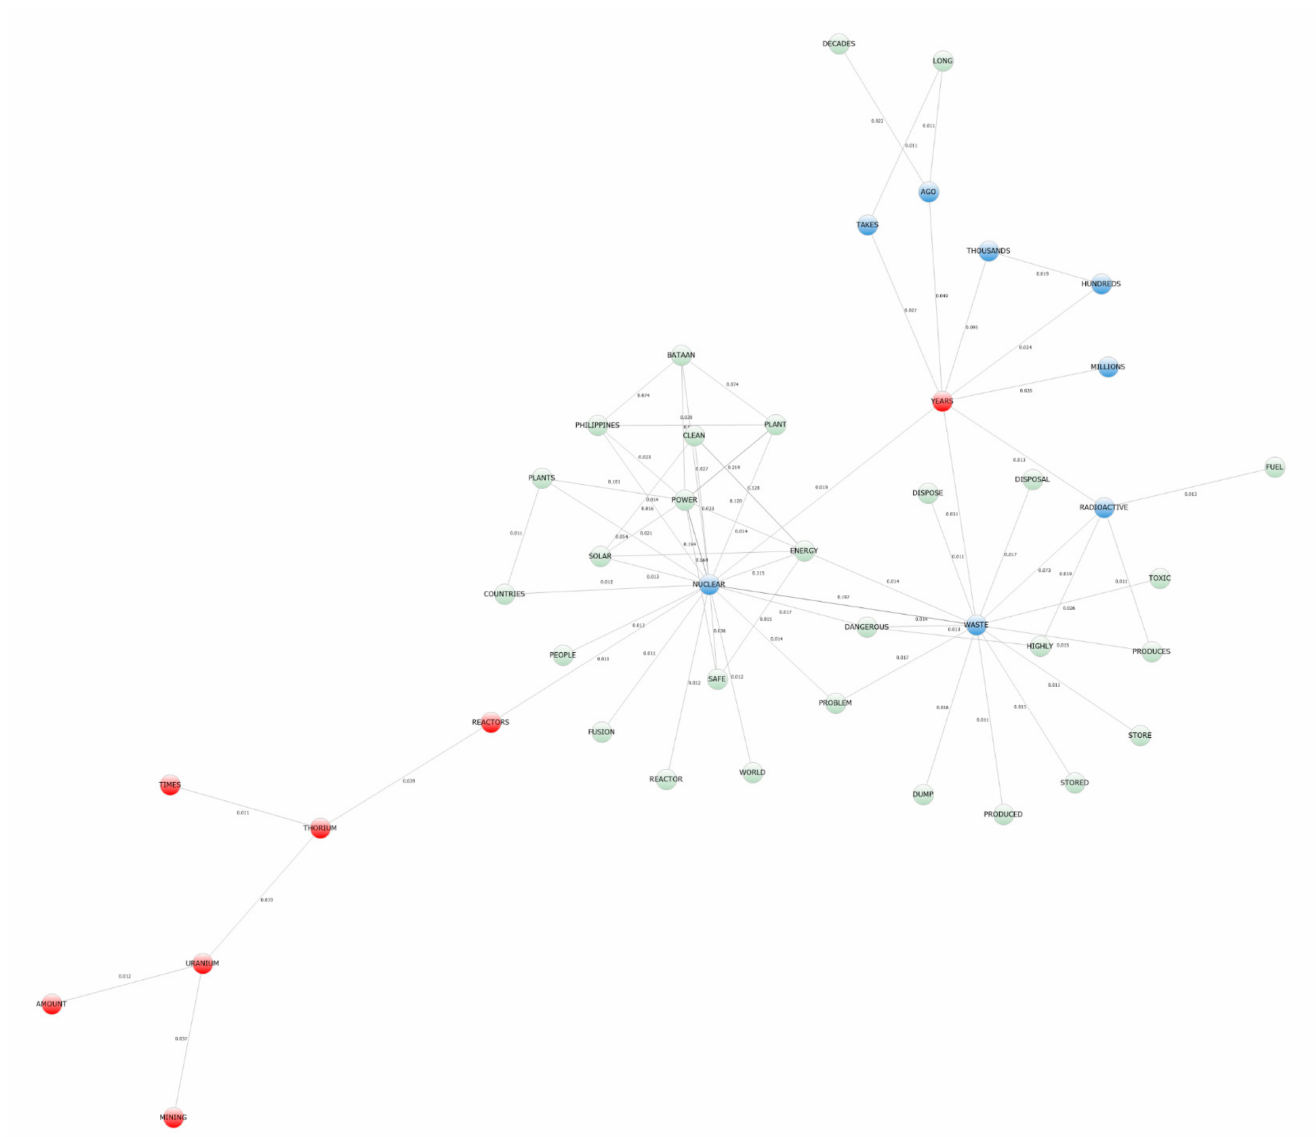
Figure 1. Proximity plot (comments on the Nas daily